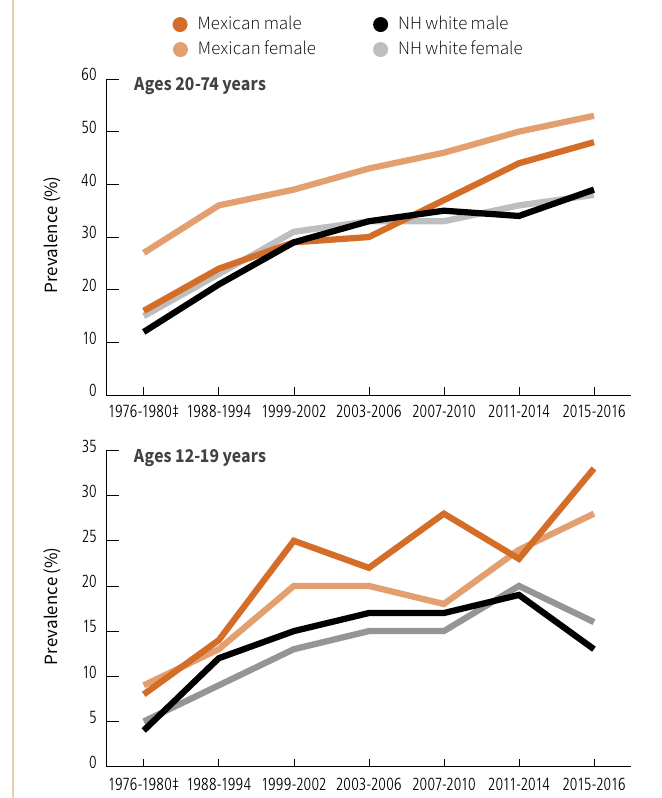
Figure 9. Obesity* (%) Trends in Mexican Americans and Non-Hispanic Whites by Age, US,